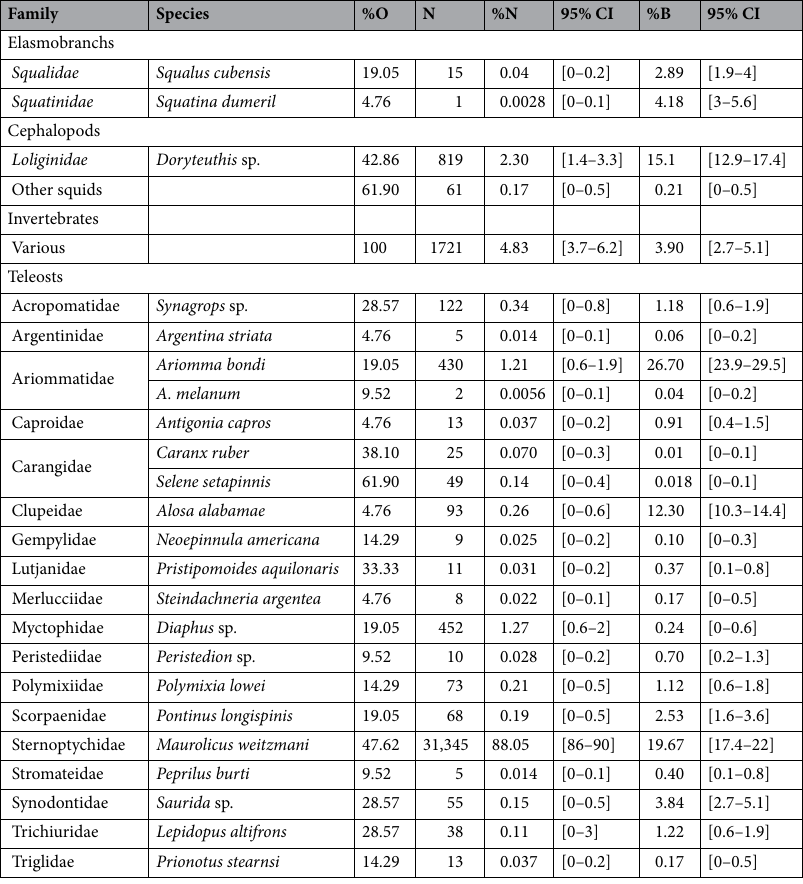
Table 1. Composition of the nektonic community in the northeastern Gulf of Mexico, where %O is the occurrence; N is the number of fish collected; %N is the relative abundance; 95% CI is the confidence intervals at 95%, %B is the percentage in